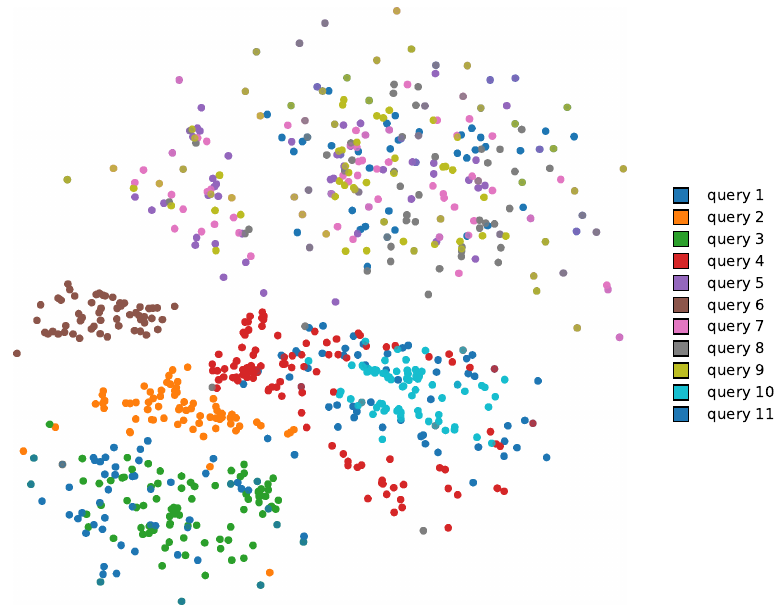
Figure 5. Visualization of tail entities in RESCAL using T-SNE. A point represents a tail entity. Points in the same color represent tail entities that have the same context